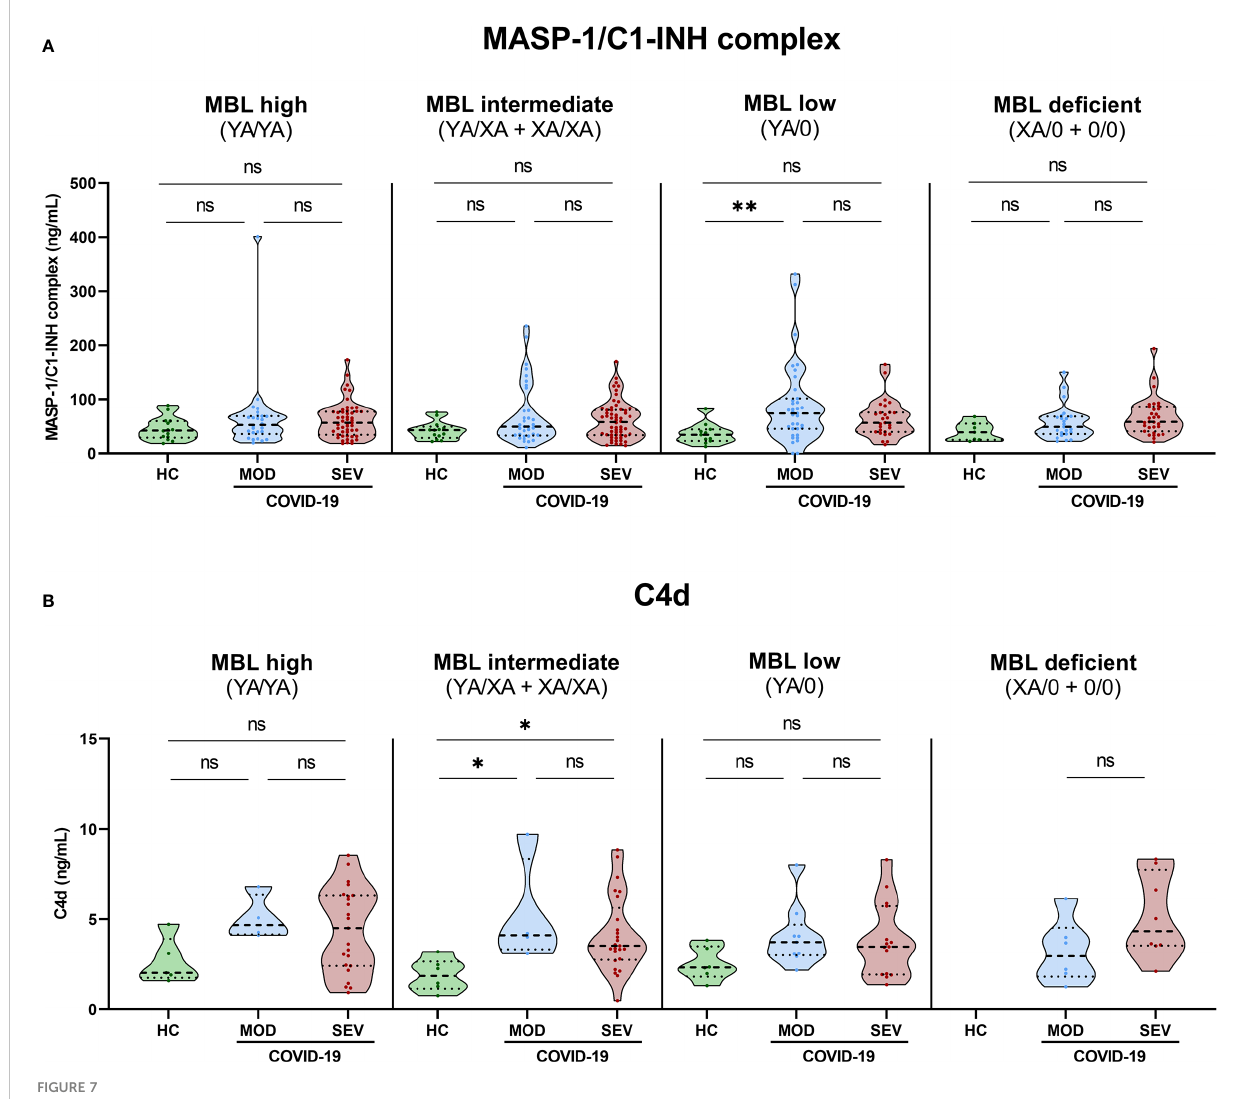
FIGURE 7 MASP-1/C1-INH complex and C4d levels in healthy controls and COVID-19 patients, strati fi ed according to MBL2 genotype groups and disease severity. Short MBL2 haplotype combinations were merged into four different groups: 1) MBL high (YA/YA), 2) MBL intermediate (YA/XA+XA/XA), 3) MBL low (YA/0 (including YA/YB, YA/YC and YA/YD)), and 4) MBL de fi cient (XA/0+0/0 (including 0/0 for allele A, XA/YB, XA/YC and XA/YD)). After genetic grouping, groups were furthermore strati fi ed according to disease severity, and MASP-1/C1-INH complex (A) as well as C4d levels (B) were compared within groups using ANOVA with Dunn ’ s multiple comparison post-hoc test. Asterisks indicate signi fi cant results between severity groups (* p<0.05, ** p<0.01). HC, Healthy controls; HOSP, Hospitalized patients not requiring ventilation; HOSP+O 2 , Hospitalized patients requiring ventilation; ICU, Intensive care unit patients; MOD, moderate patients group; SEV, severe patients group; ns, non-signi fi